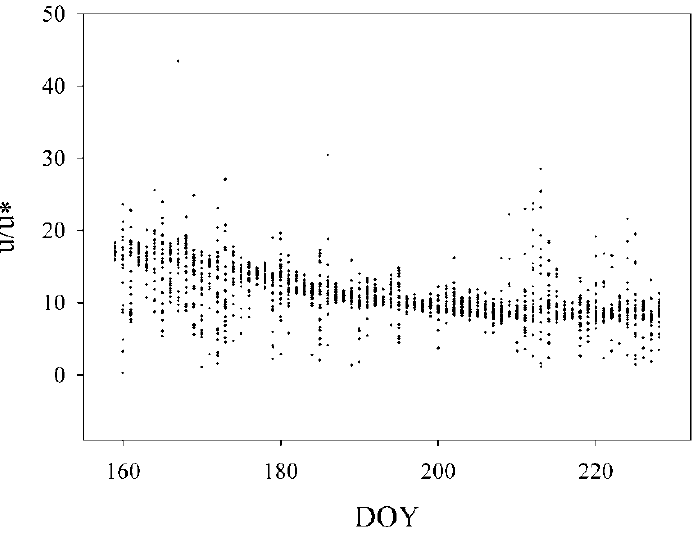
Figure 5. The change in the ratio u/u* over time as the crop canopy develops for NE field. The difference in each footprint model under both stable and unstable atmospheric an MBE of − 0.03 mm h − 1 ( − 3.16%) and an RMSE of 0.12 mm h − 1 (12.75%). However,